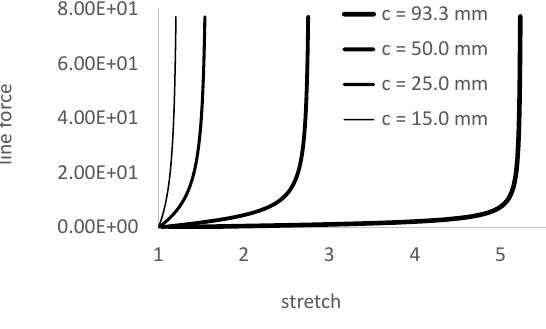
Figure 8: Deformed configuration for the symmetric laminate ob- tained with a commercial FEM program